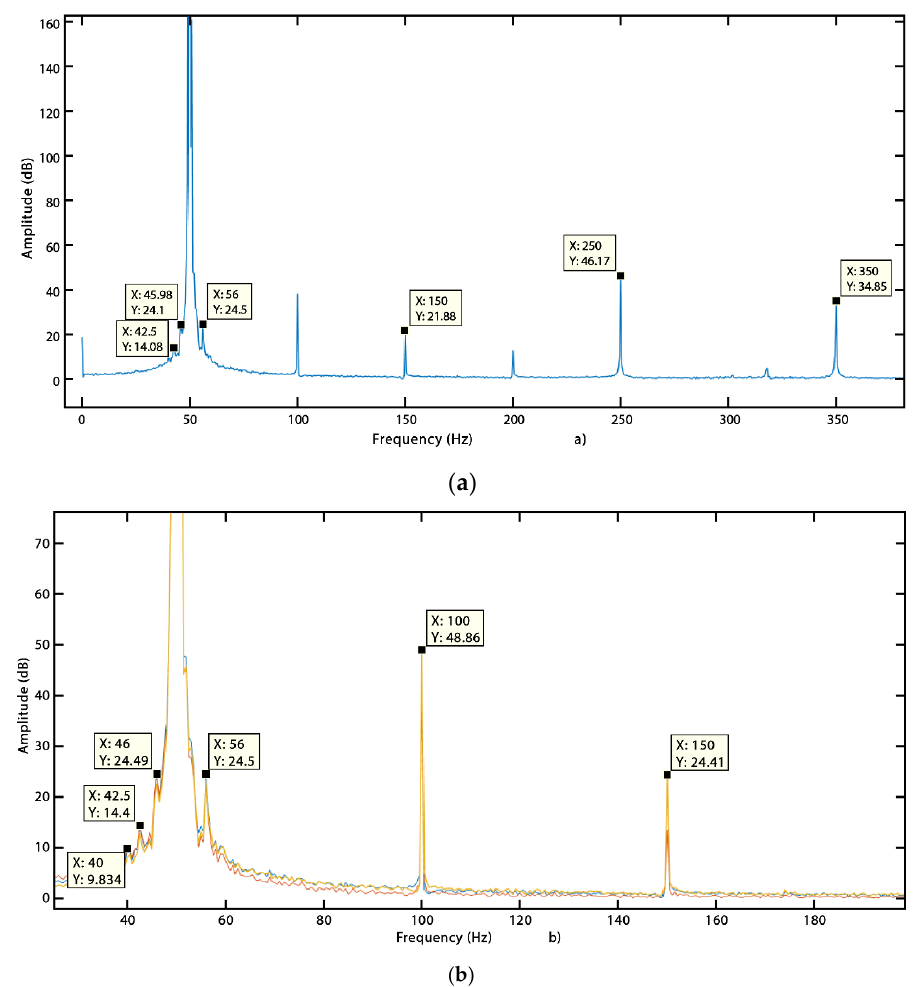
Figure 2. FT of the WT current signal. ( a ) One phase and ( b ) three phases.